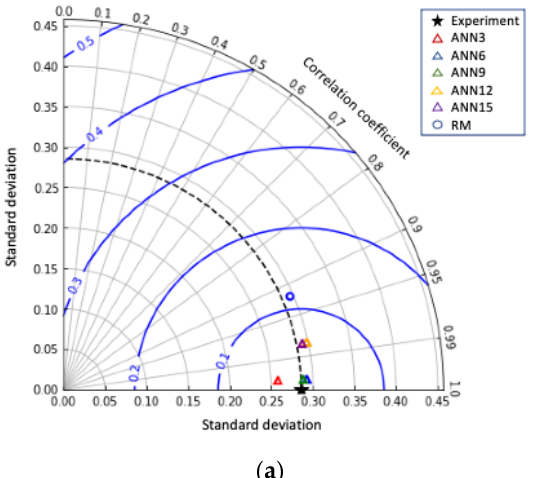
Figure 8. Predicted values of the bulk drag coe ffi cient against variables; ( a ) Δ h/h o , ( b ) Δ V/V o , ( c ) A f , ( d ) R e , ( e ) W v and ( f ) λ .